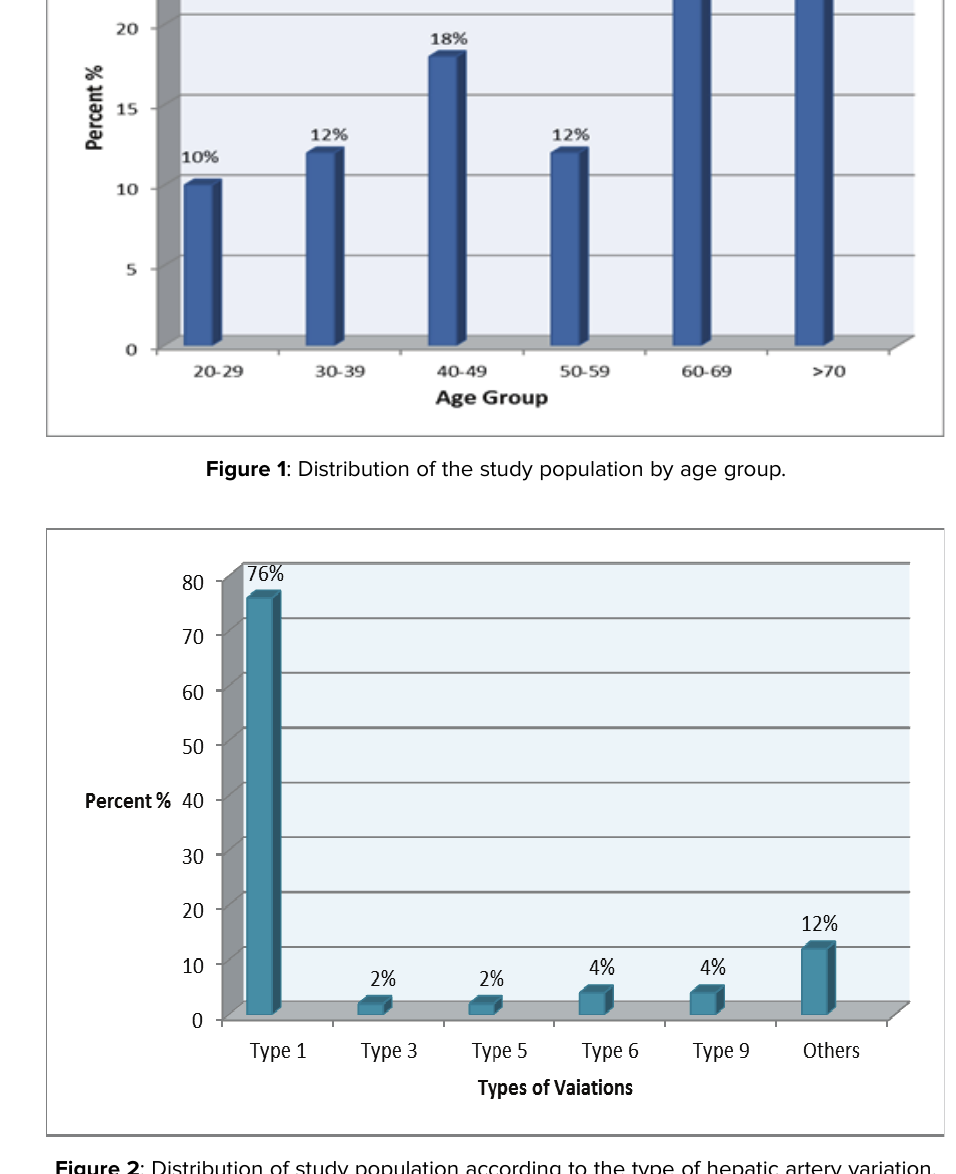
Figure 2 : Distribution of study population according to the type of hepatic artery